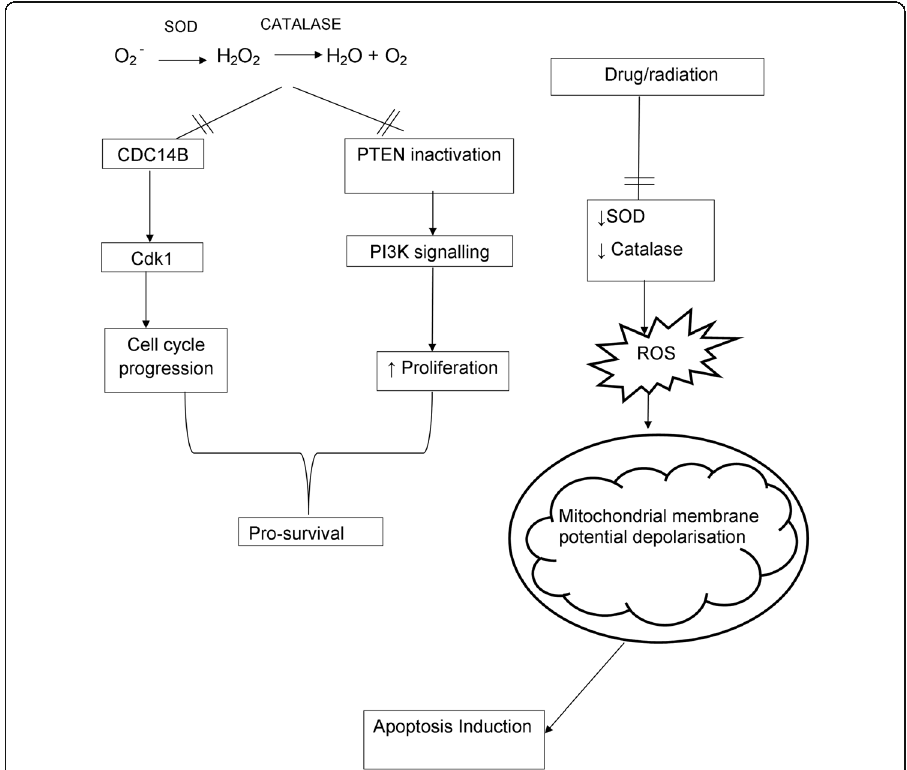
Fig. 2 Tumourigenic ROS signalling. ROS inhibits PTEN activity that results in increased augmentation of PI3K/ Akt signalling and subsequently promotes proliferation. Furthermore, ROS promotes cell cycle progression by means of inhibiting phosphatase Cdc14B resulting in the activation of cyclin dependent kinase 1 (Cdk1).